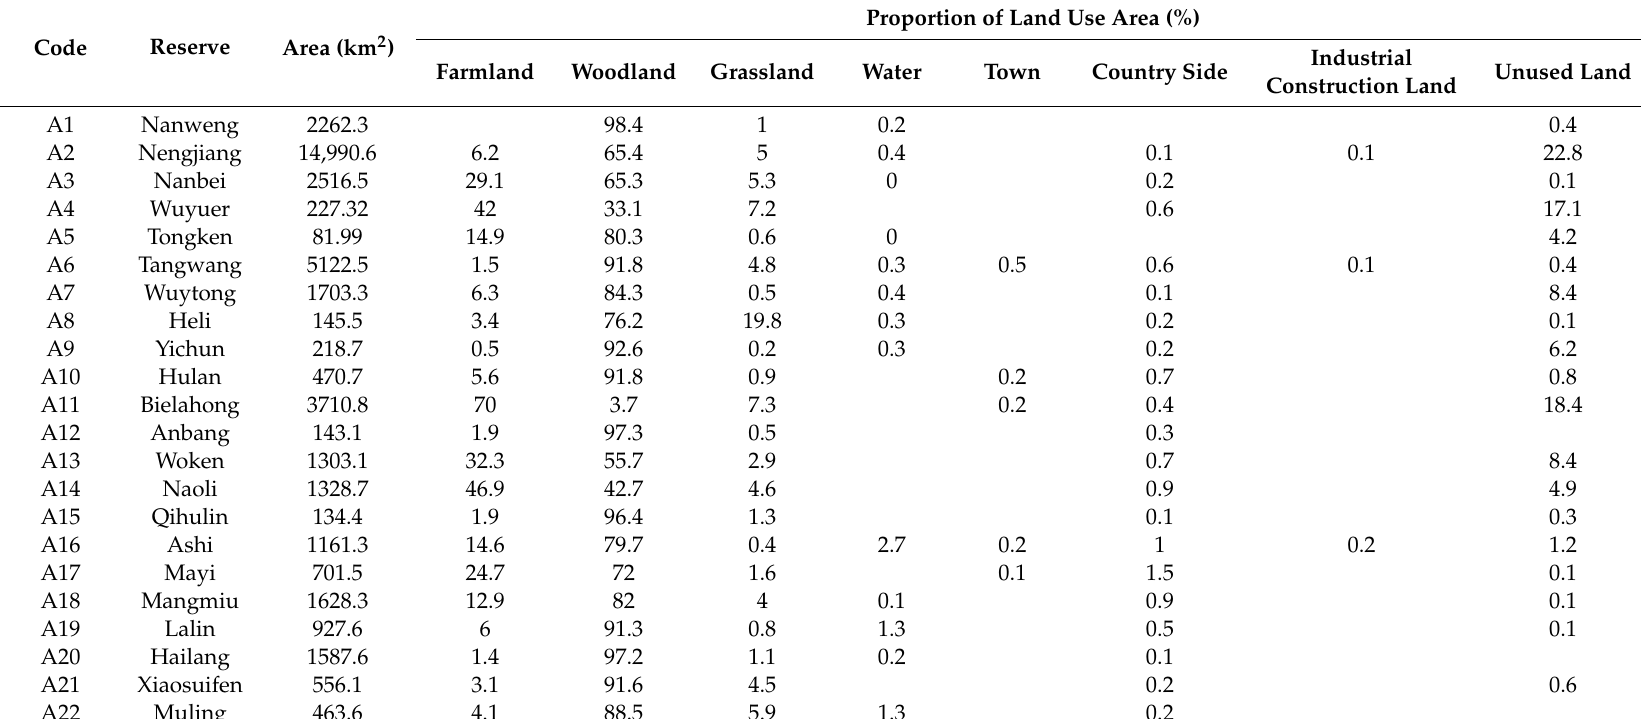
Table 1. Land use types and catchment areas of di ff erent water environment function